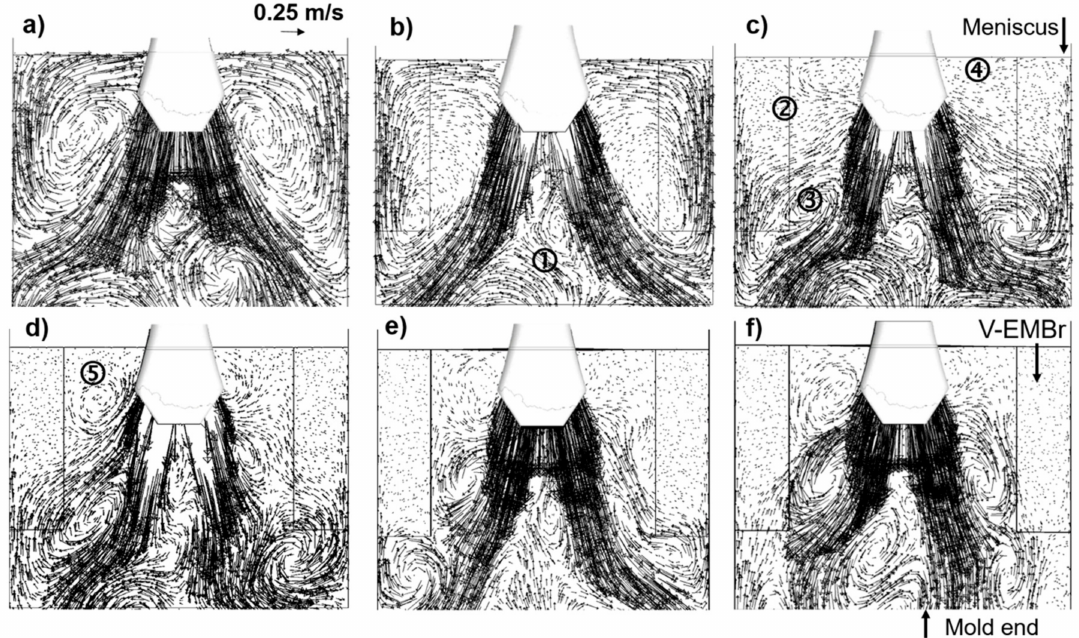
Figure 7. Velocity vectors at the central symmetrical plane of the mold with di ff erent intensities of V-EMBr, ( a ) 0, ( b ) 0.1, ( c ) 0.2, ( d ) 0.3, ( e ) 0.3 and ( f ) 0.5